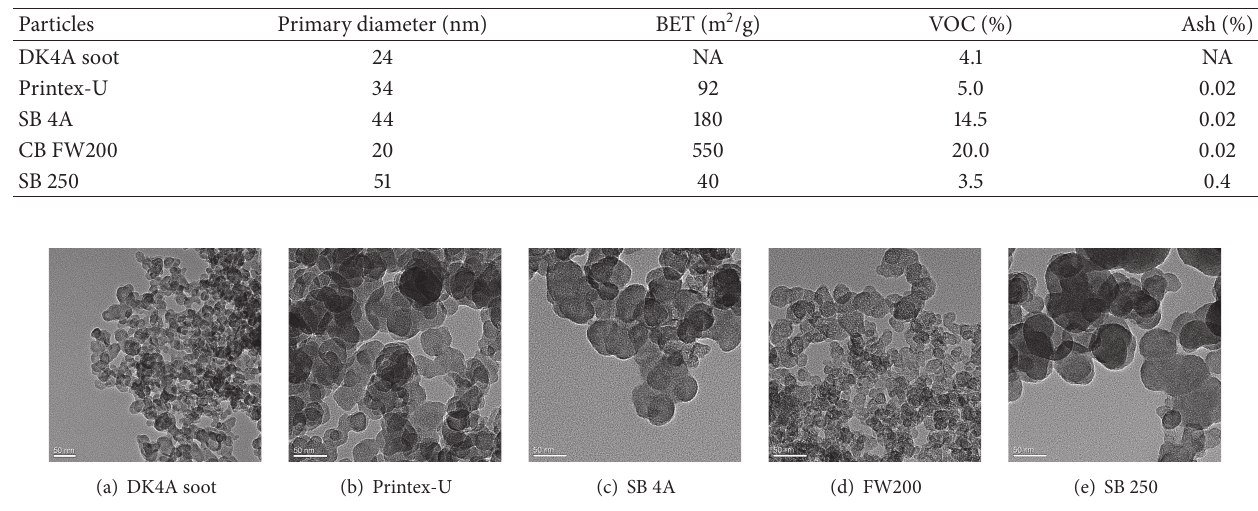
Table 1: The parameters of different particles.